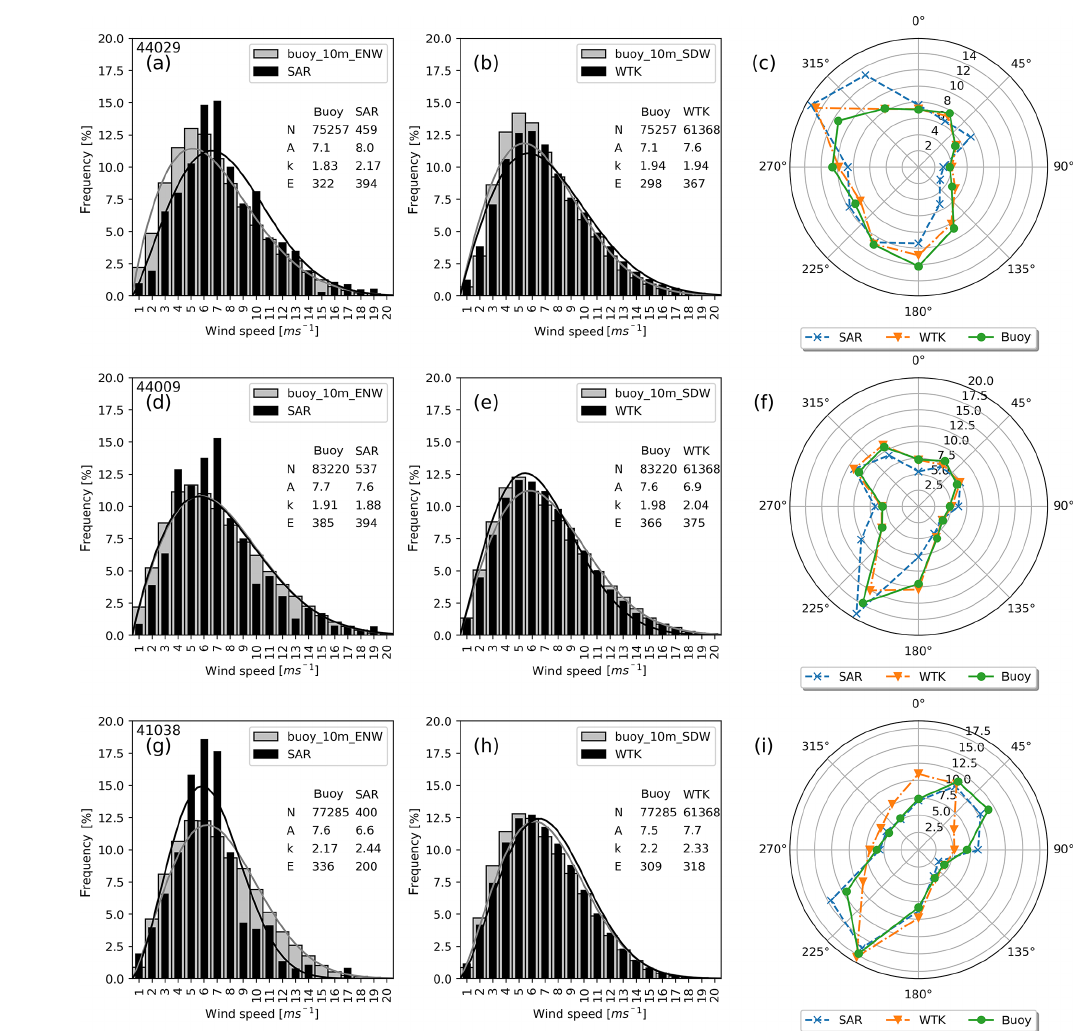
Figure 5. Weibull fits and wind roses for buoys 44029 (a–c) , 44009 (d–f) , and 41038 (g–i) . SAR on the left (a, d, g) , WTK in the mid- dle (b, e, h) , and wind roses for buoy, SAR, and WTK on the right (c, f, i) . Key characteristics are given in the tables: number of observa- tions ( N ), Weibull shape ( A ) in metres per second, Weibull scale ( k ), and the energy density ( E ) in watts per square